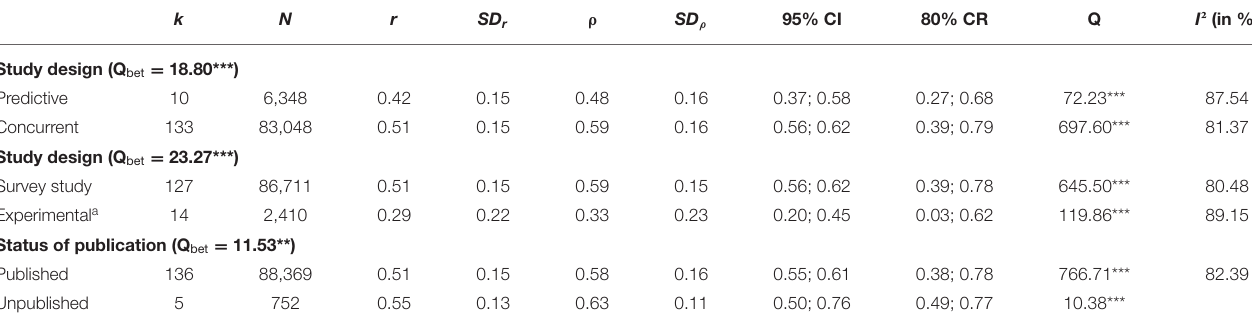
TABLE 4 | Subsample analyses for study and population